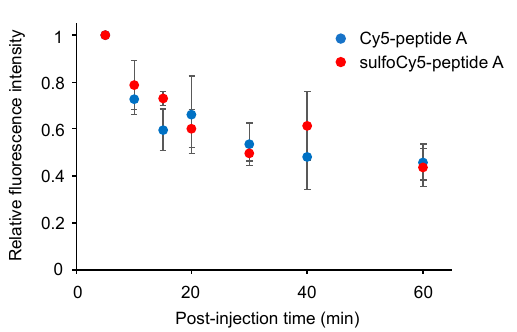
10. Figure 7 is updated as: